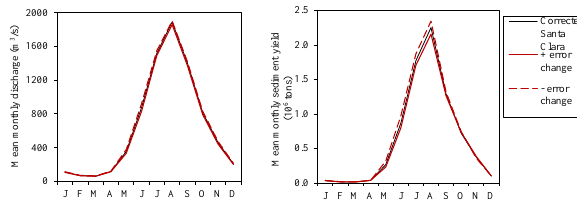
Fig. 3. Sensitivity of the discharge (left) and sediment yield